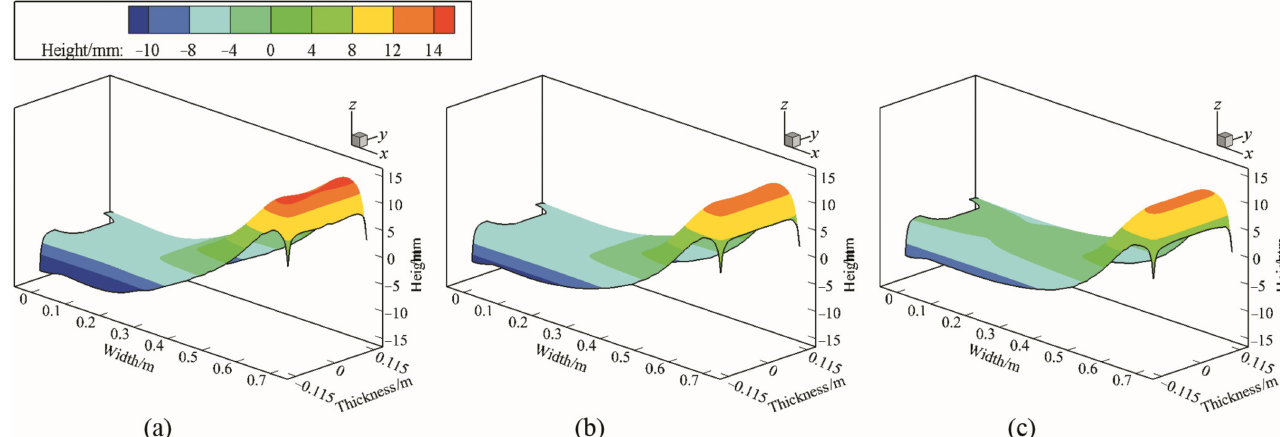
Figure 10. Steel–slag two–phase interface fluctuation profiles in the mold with ruler EMBr under different SEN depths: ( a ) D SEN = 130 mm, ( b ) D SEN = 150 mm, and ( c ) D SEN = 170